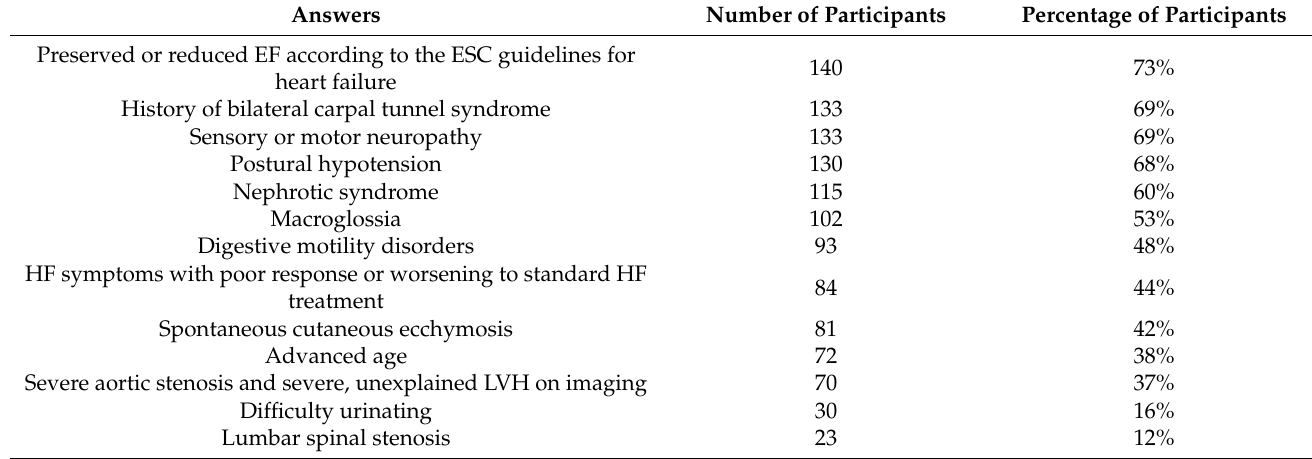
Table 1. Clinical features of heart failure that would raise the suspicion of a possible diagnosis of cardiac amyloidosis in our Answers Number of Participants Percentage of Participants Preserved or reduced EF according to the ESC guidelines